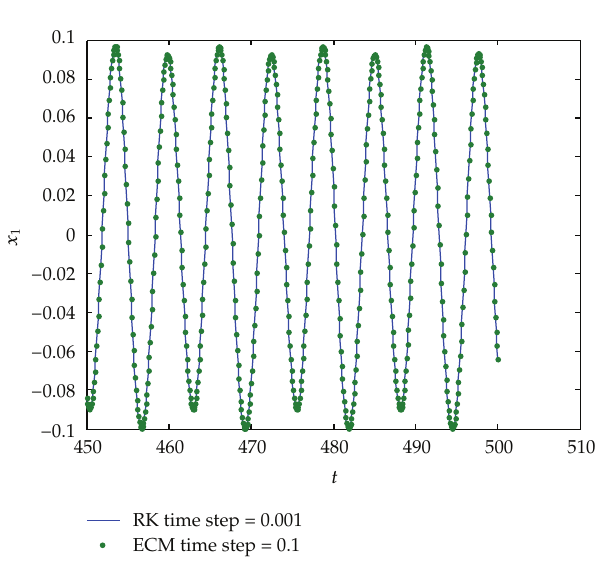
Figure 11: Displacement